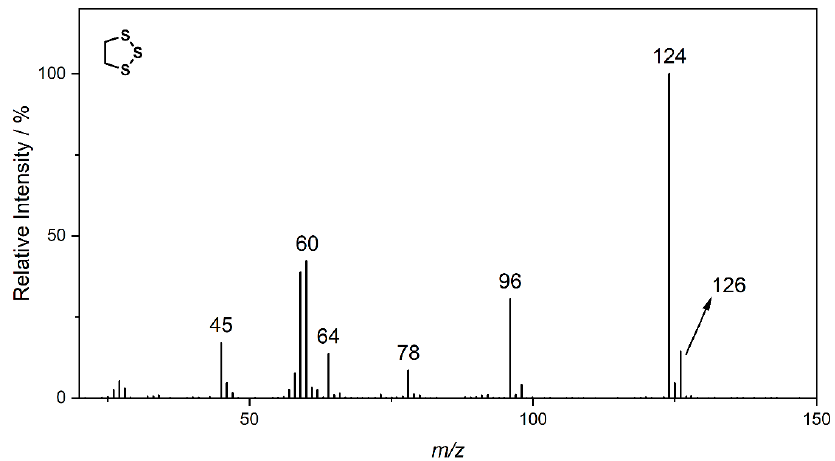
Figure 5. Fragment pattern of compound B eluting at a retention time of 11.25 min (Figure 4). The m / z ratio of prominent fragments is given at the respective signals. The fragment pattern is assigned to 1,2,3-trithiolane by the NIST11 database.